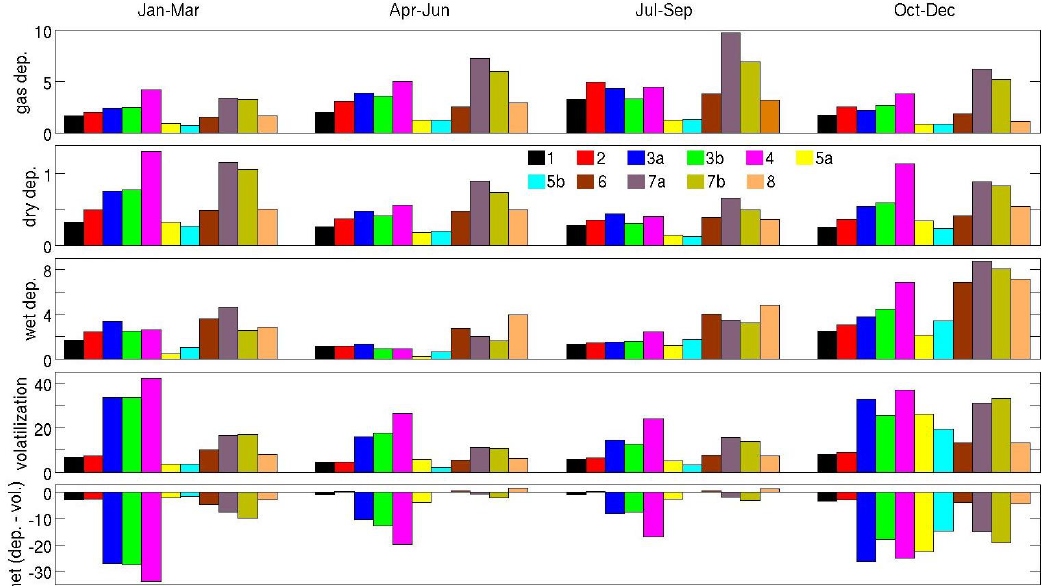
Figure 11. Bar charts of integrated quarterly (3 month) fluxes (kg) by ICES boxes (Figure 1) of PCB 153 in 1996: gas deposition ( top row ), dry deposition ( 2nd row ), wet deposition ( 3rd row ), volatilization ( 4th row ), and net air-sea exchange ( bottom row ).